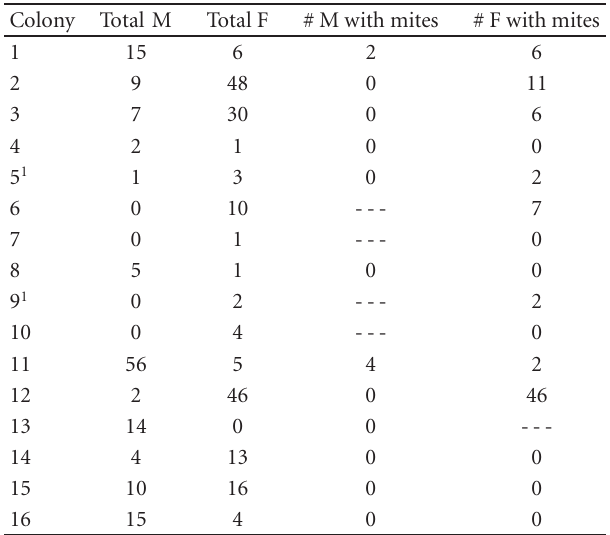
Table 2: Total number of male (M) and female (F) alates collected per colony of the ant Messor pergandei and abundance of associated phoretic mites.